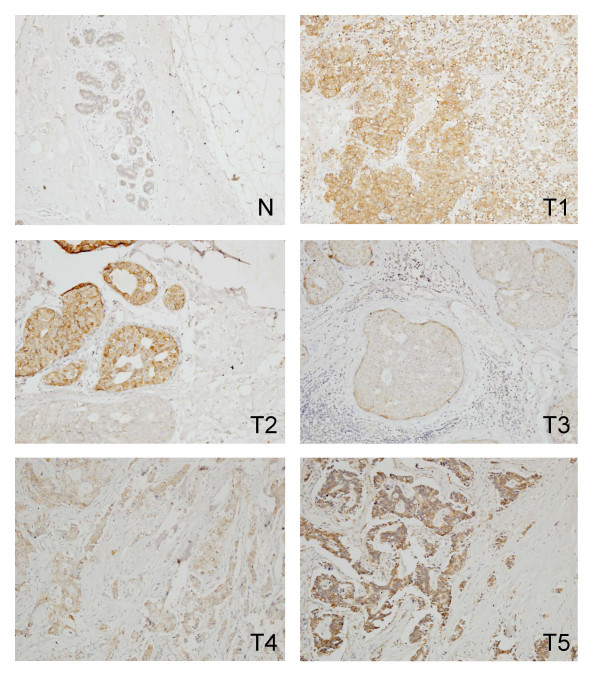
Immunohistochemistry of eEF1A2 in the breast. The panel labelled N shows the antibody staining weakly in a normal breast section. Panels T1 to T5 show breast tumours staining strongly with the anti-eEF1A2 antibody. Magnification ×10.